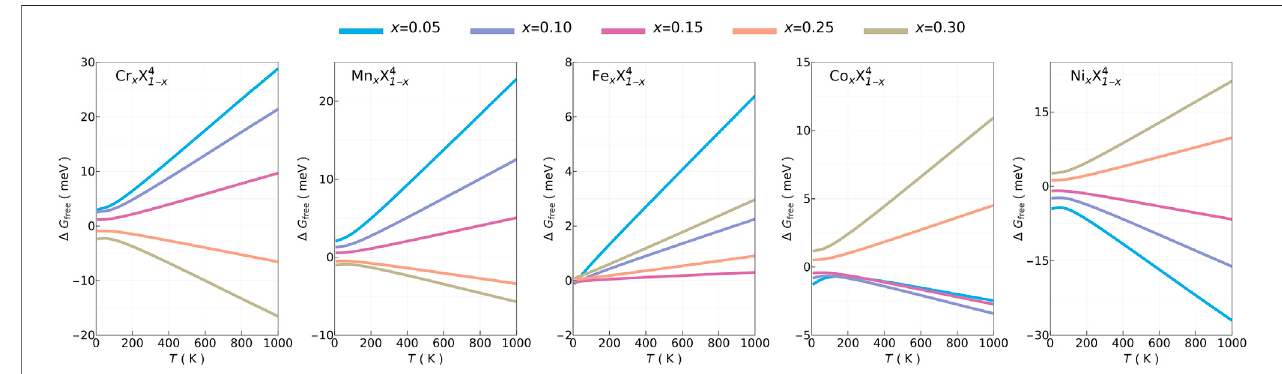
FIGURE 2 | Temperature dependence of Gibbs free energy differences ( Δ G free ) of non-equimolar fi ve-principal-elements high-entropy alloys with respect to CrMnFeCoNi (X 5 ). Note that the vertical scale is not the same for these plots.